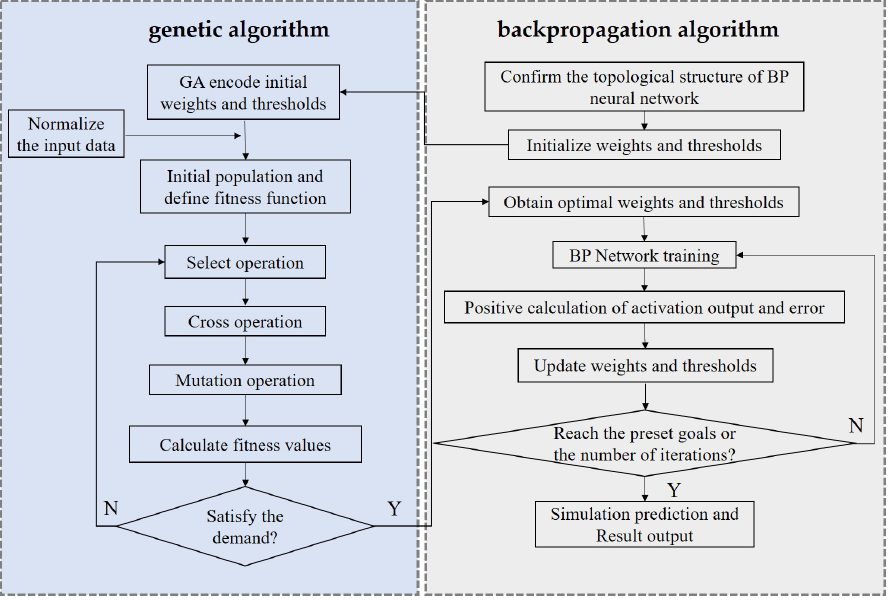
Figure 3. Algorithm flowchart of the GA-BP neural network